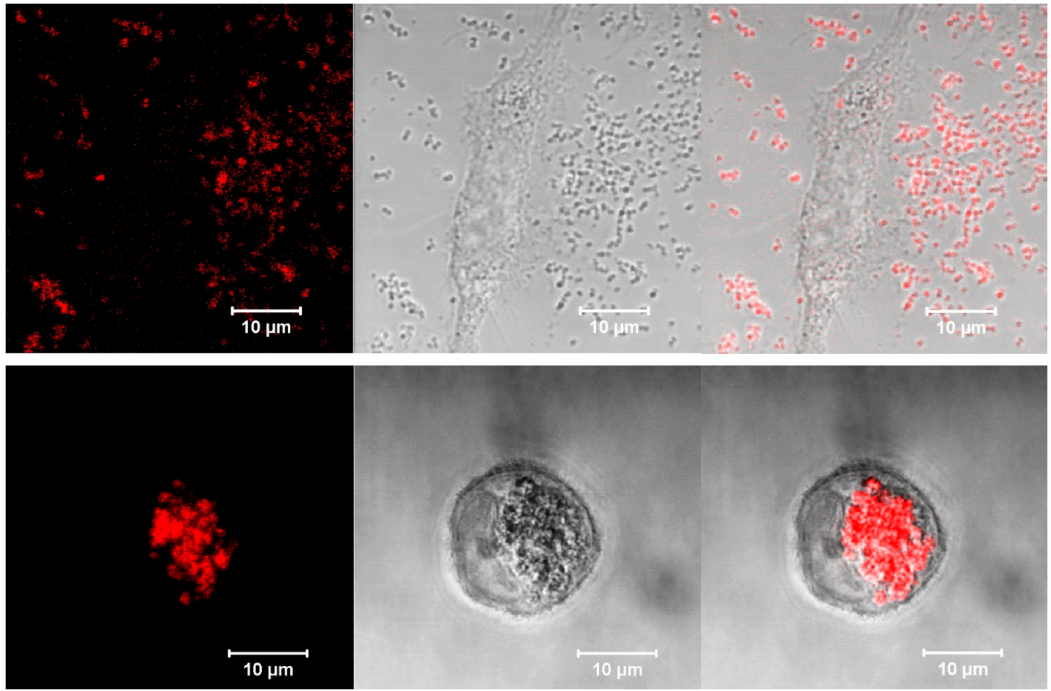
Figure 8. Representative CLSM images in fluorescence, transmission and overlay modes of a Beas-B2 cell (upper panel) and an A549 cell (lower panel) after 24 h culturing with DOX-HSA-MPs (5000 particles per cell). Fluorescence mode was accessed with excitation of DOX at 488 nm and long pass emission filter 530